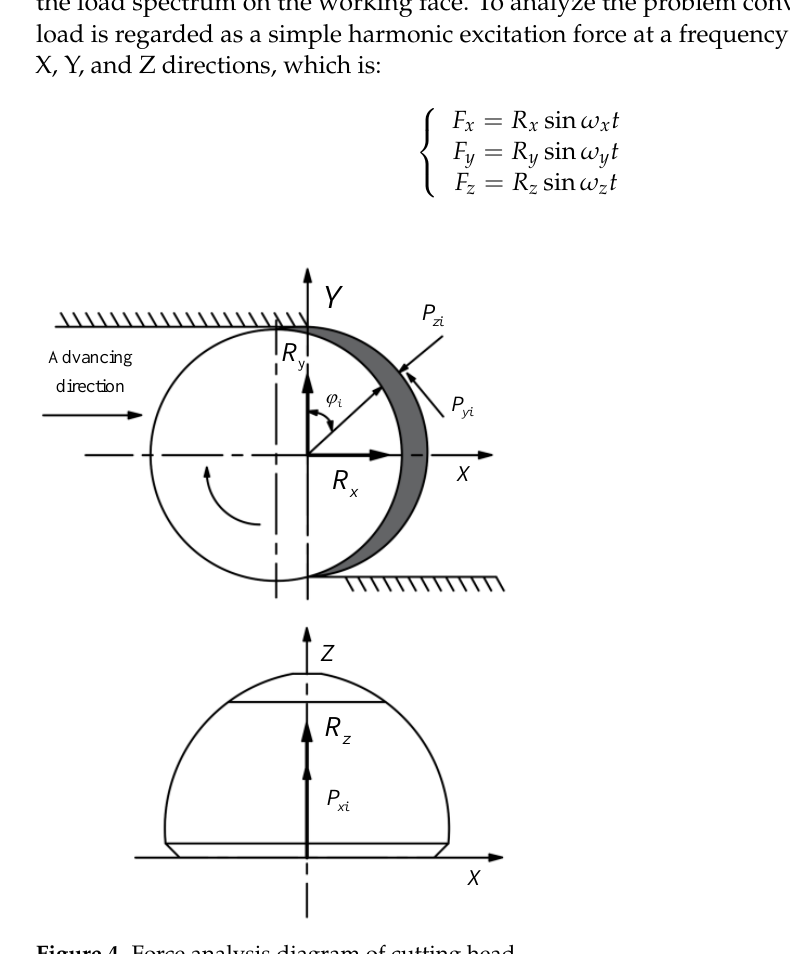
Figure 4. Force analysis diagram of cutting head.